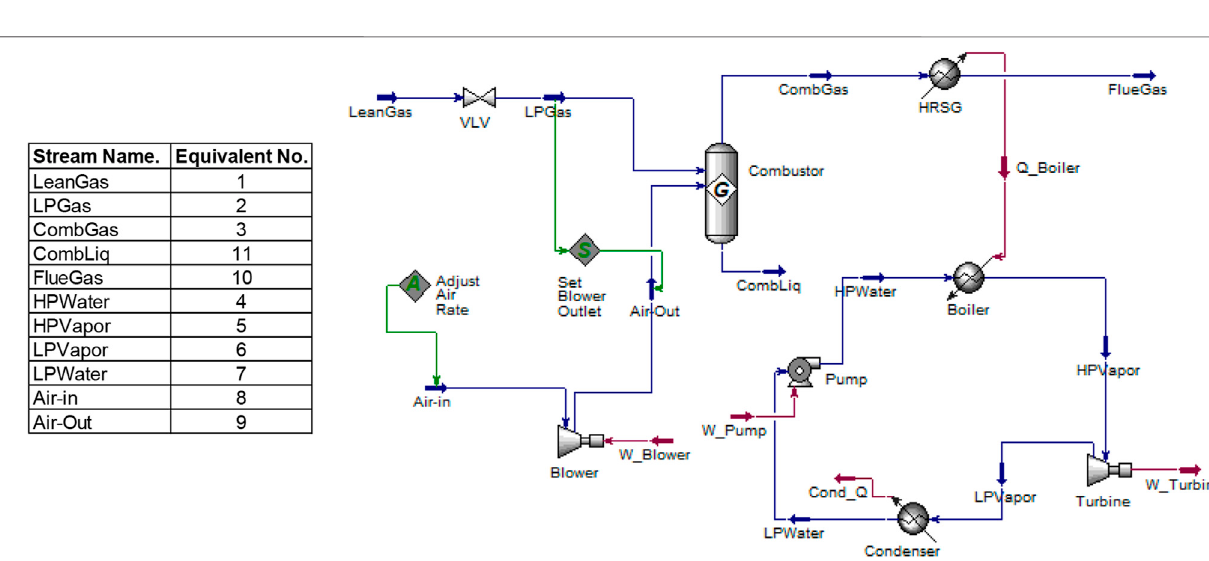
FIGURE 4 | HYSYS modeled steam power plant